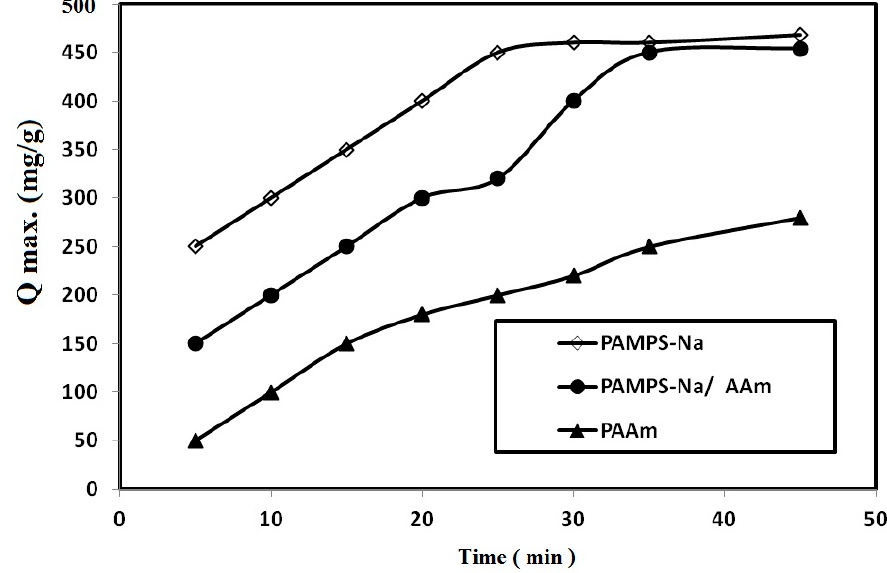
Figure 6. Relation between adsorption capacities of silica-nanogel composites for 1000 ppm of MB and equilibrium adsorbtion time at constant ionic strength 1 M.